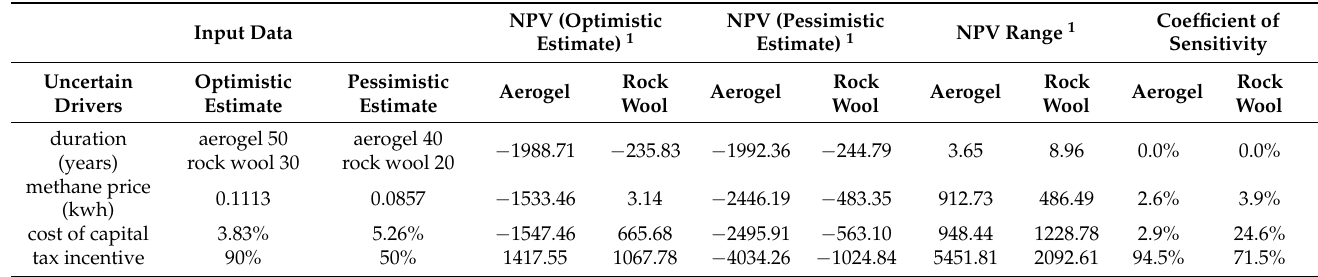
Table 10. Sensitivity Analysis of the NPV.